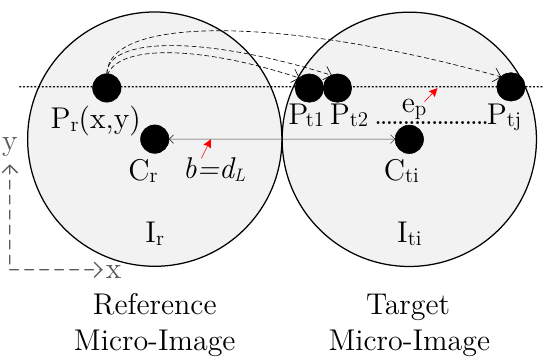
Figure 11. Stereo-matching between reference and target